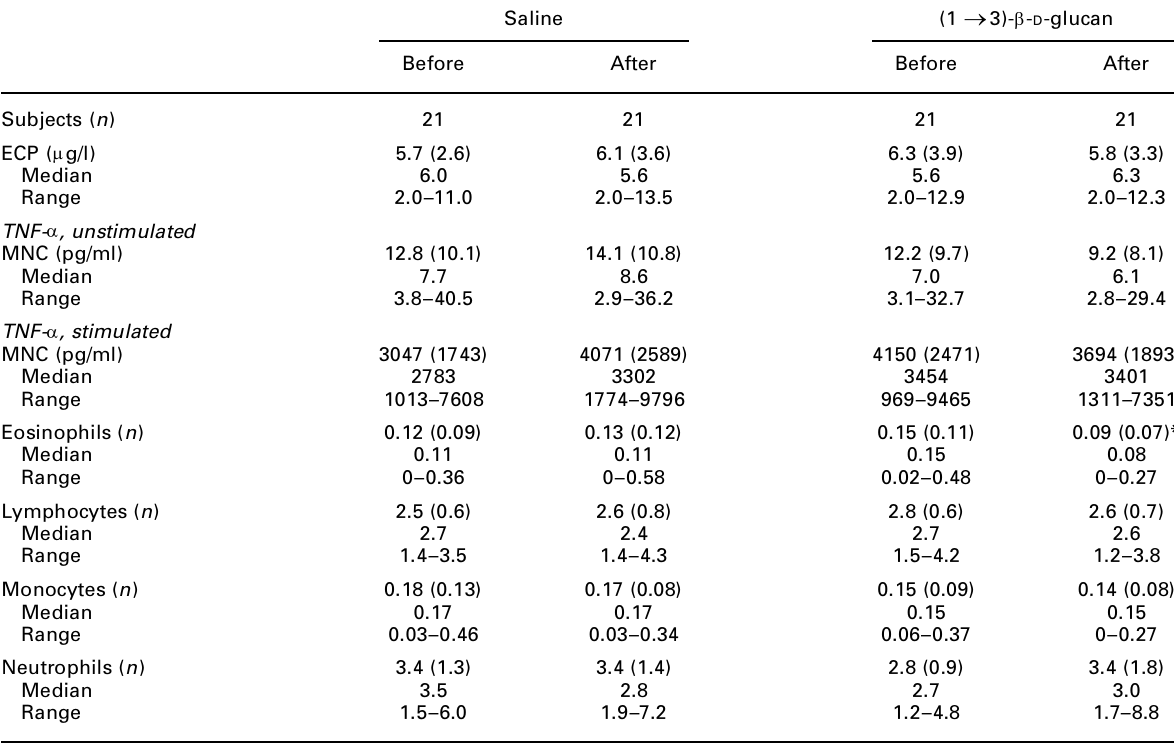
Table 2. Amounts of TNF- a in unstimulated and stimulated MNC and ECP as well as the number of cells (x 10 9 /l) in blood